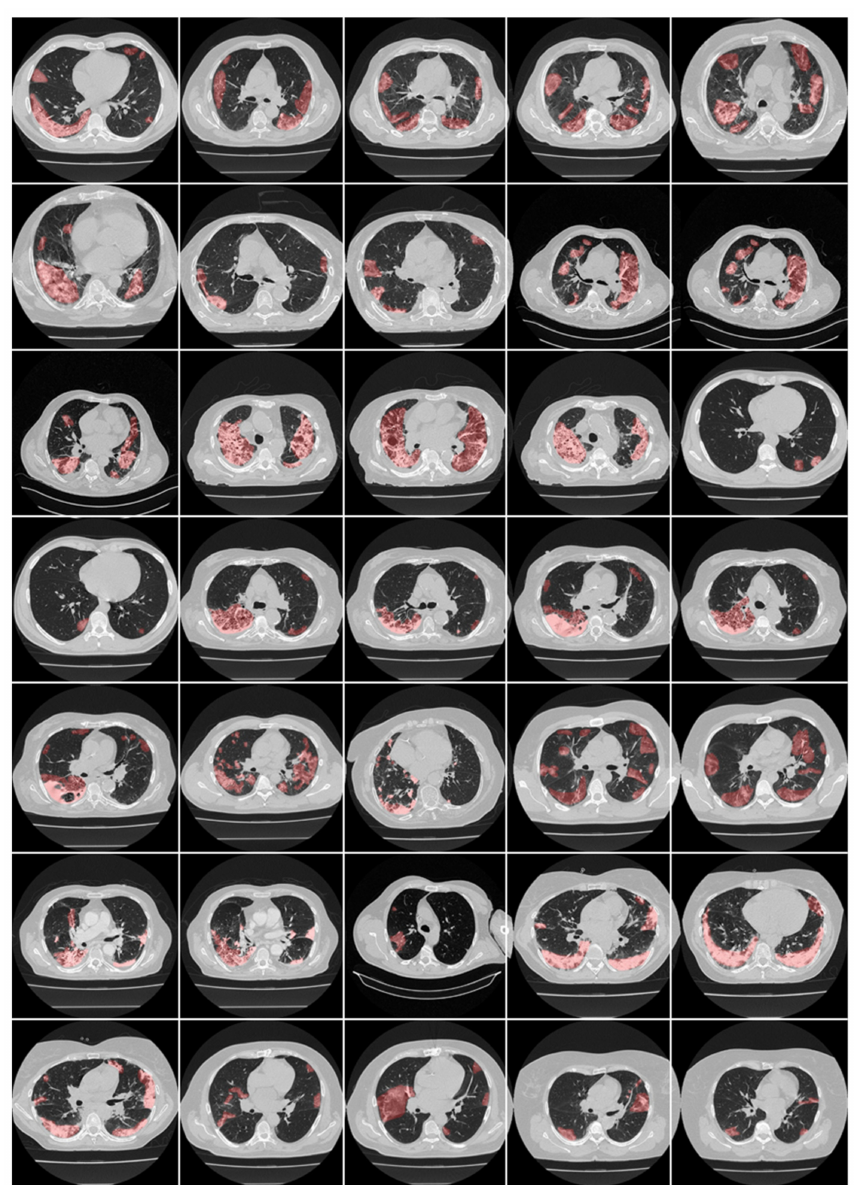
Figure 12. Manual lesion delineation overlays (red) from tracer 1 on raw CT lung images (Courtesy of AtheroPoint™, Roseville, CA, USA permission